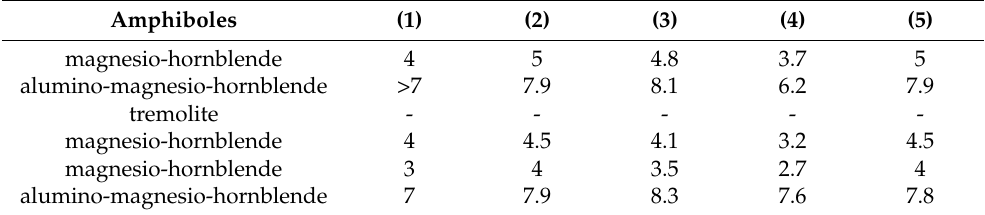
Table 6. Amphiboles from inclusions in PGM grains, with P estimates (kbar). Amphiboles